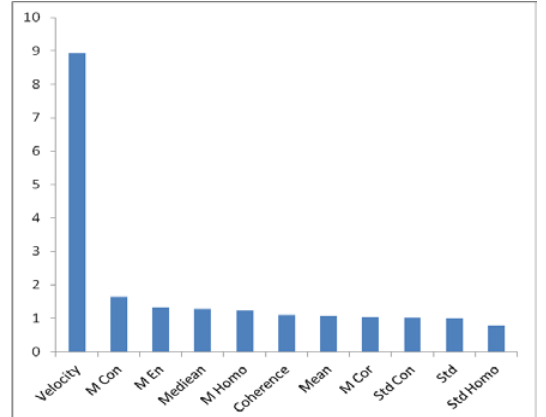
Fig. 11. Glacier outline (yellow line) determination result plotted on the gray scale SAR image. Red box: glacier area failed to be